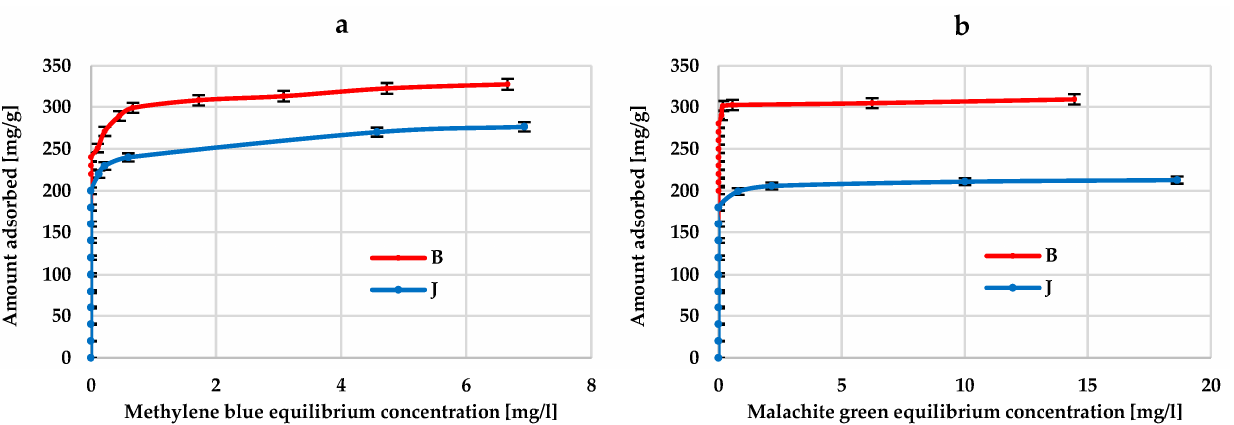
Figure 7. The equilibrium isotherms of methylene blue ( a ) and malachite green ( b ) adsorption on the carbonaceous materials derived from the used carbon filters. Table 3. Langmuir and Freundlich parameters of the isotherms of methylene blue and malachite green adsorption on the carbonaceous materials derived from the used carbon